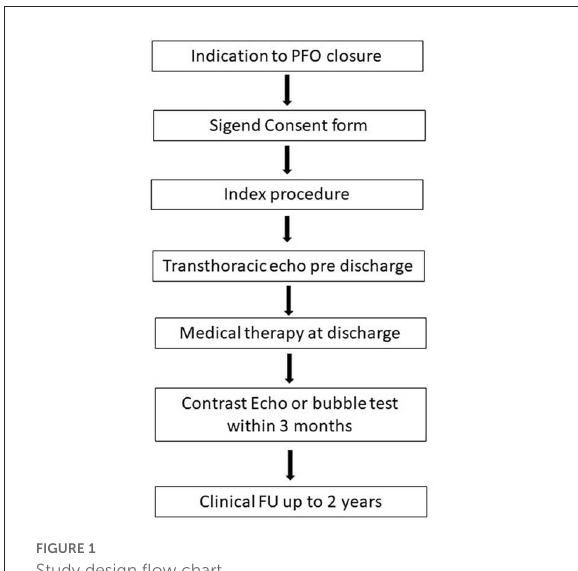
FIGURE1 Study design flow